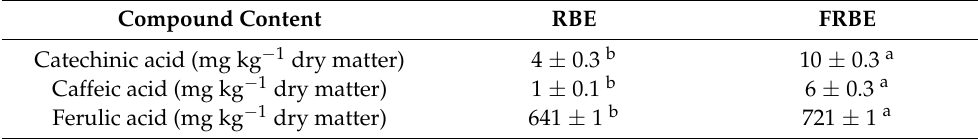
Table 2. The phenolic acid composition of water-soluble rice bran